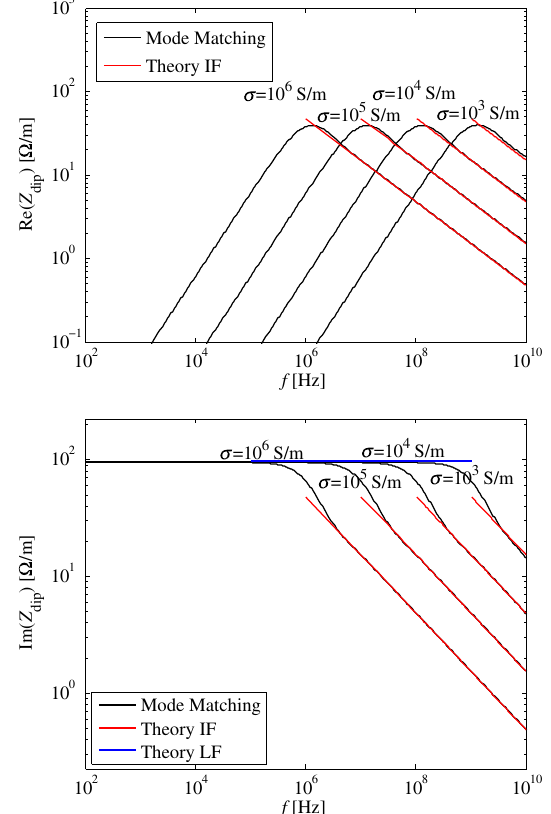
FIG. 6. Comparison between mode matching and the classical theory of resistive wall of [18,20] real and imaginary part of the transverse impedance. Mode matching parameters: b ¼ 5 cm, t ¼ 500 μ m, L ¼ 20 cm, σ β ¼ 1 , P ¼ 10 , S ¼ 20